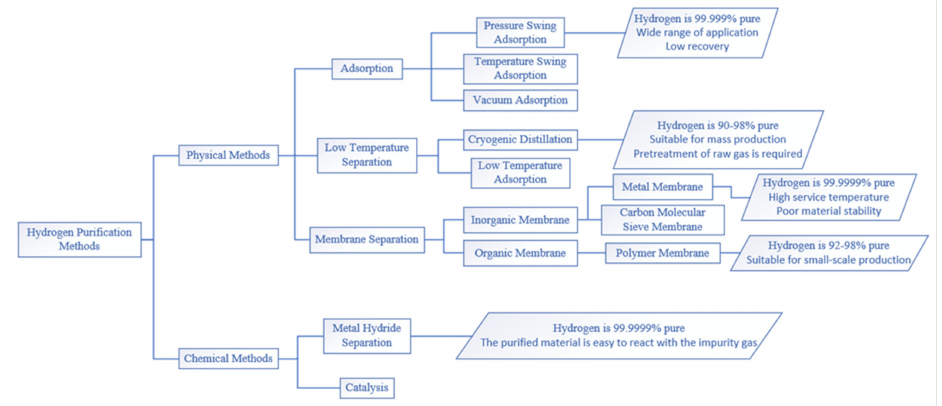
Figure 1. Classification of hydrogen purification